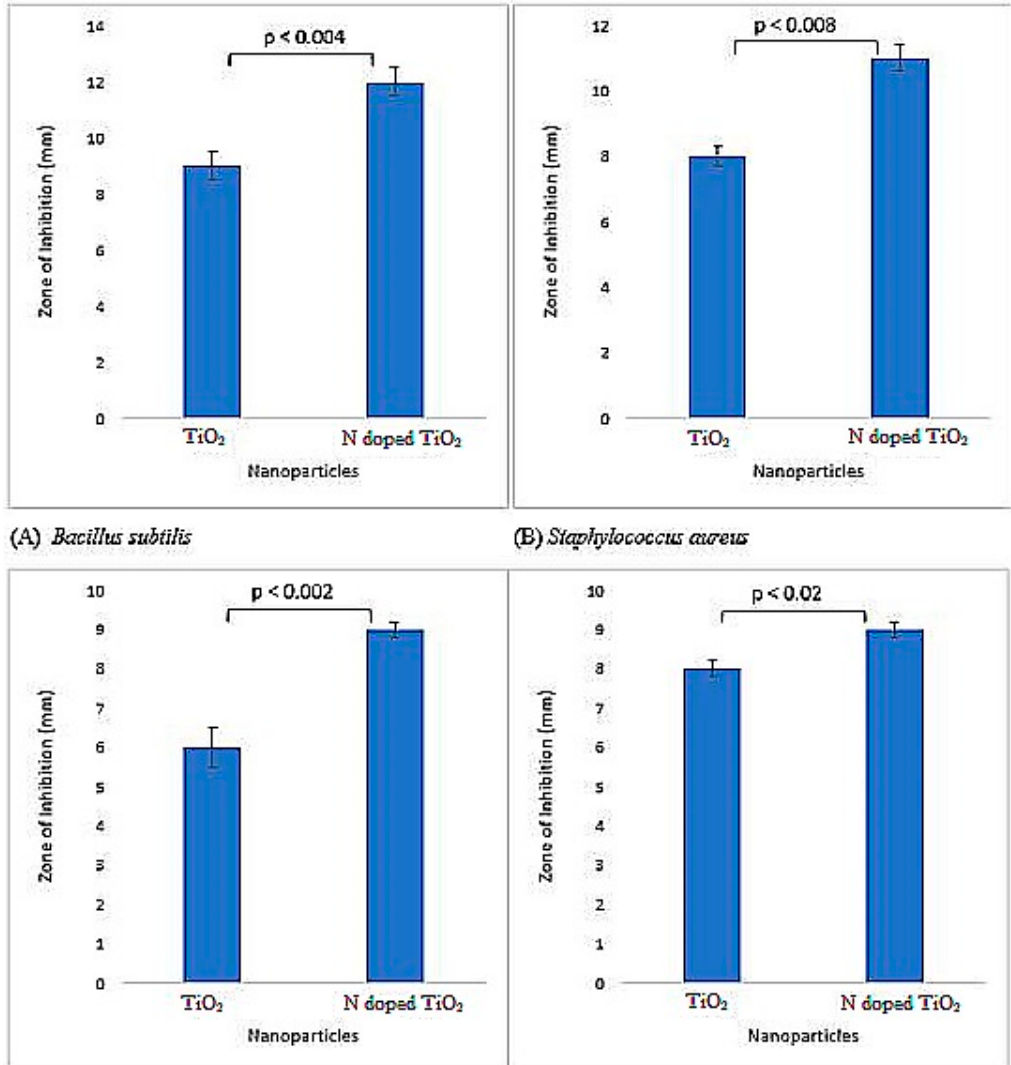
Figure 5. Antibacterial activity exhibited by TiO 2 nanoparticles and N-doped TiO 2 nanoparticles against Gram-positive bacterial strains; (A) Bacillus subtillis , (B) Staphylococcus aureus , (C) methicillin resistant Staphylococcus aureus (MRSA), (D) resistant Streptococcus haemoliticus. Error bars are shown as standard deviation on each bar. Bars are significantly different at confidence interval level of 95%.